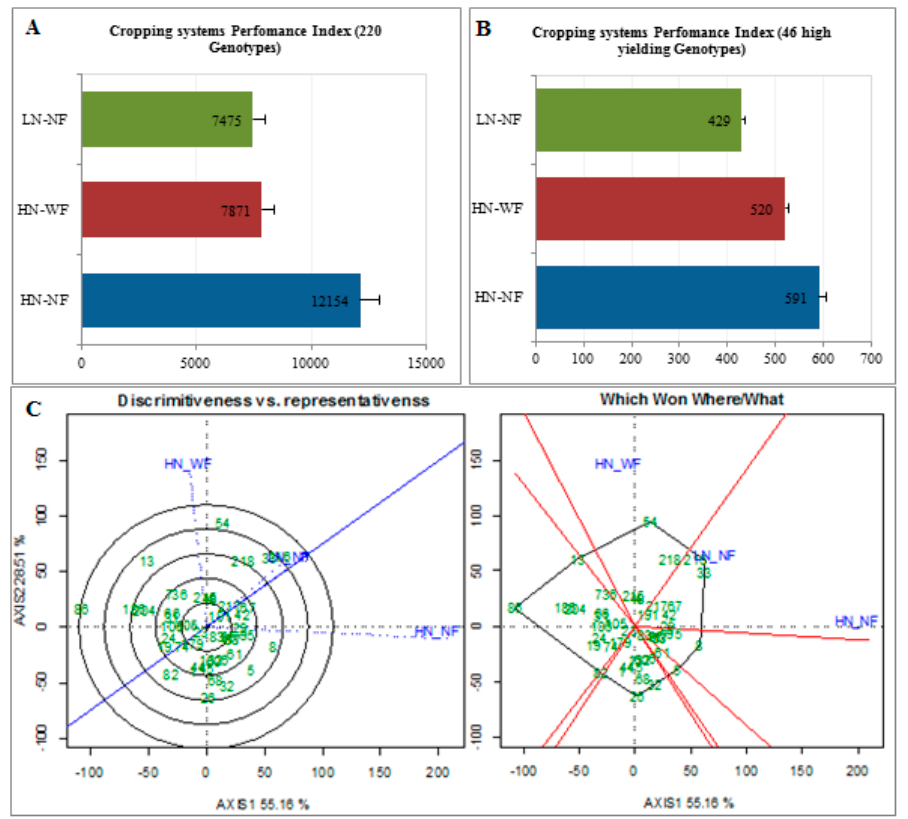
Figure 6. Graphical representation of CS performance index of ( A ) 220 cultivars and ( B ) high yielding cultivar. ( C ) Biplot of discriminativeness vs. representativeness of test environments (left panel) and the identification of winning cultivars and their related CS (right panel).